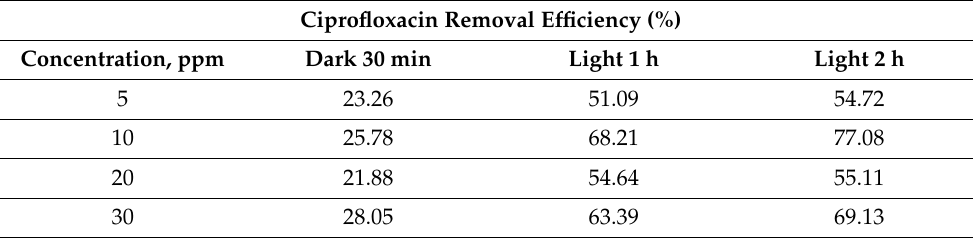
Table 4. The removal efficiency of CIP at different initial concentrations with respect to time. Ciprofloxacin Removal Efficiency (%) Concentration,